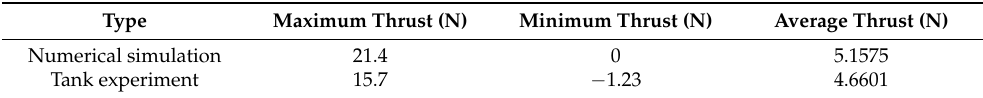
Table 5. The comparison of the tank experiment and numerical simulation results.